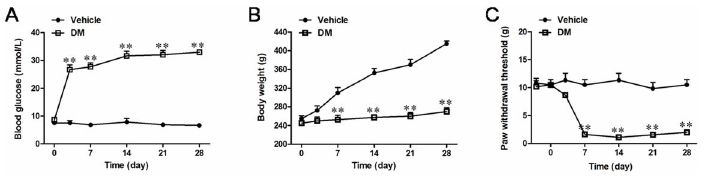
Figure 1. DM and DMA rat model induced by STZ injection. Time course of blood glucose concentration ( A ), body weight ( B ) and paw withdrawal threshold ( C ) alterations after STZ or citrate buffer (vehicle) treatment. Data are presented as mean + S.E.M. (n=30), ** P , 0.01 vs . vehicle control.